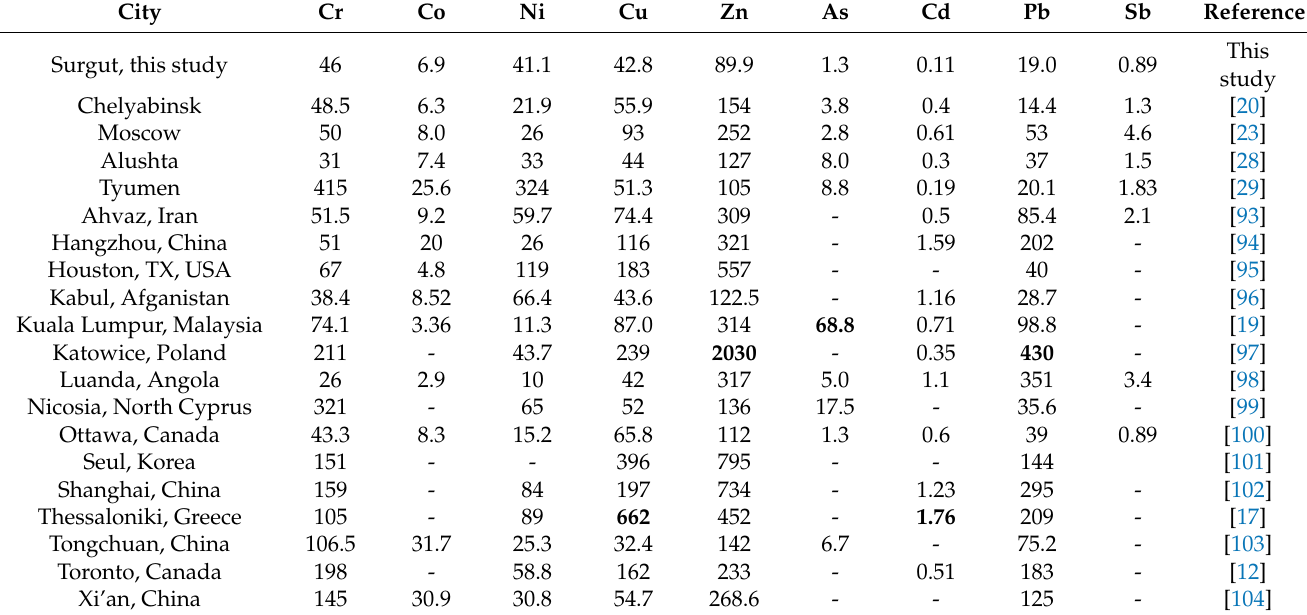
Table 6. Literature data on published metal median concentrations (mg kg − 1 ) in street dust from cities around the world.